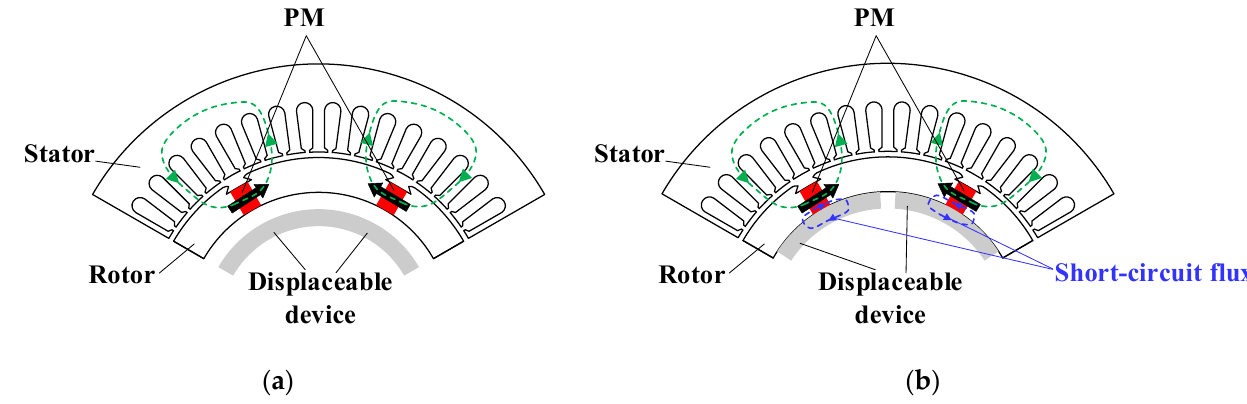
Figure 18. Illustration of the mechanism of the arc-type displaceable device [65]. ( a ) Flux-enhancing